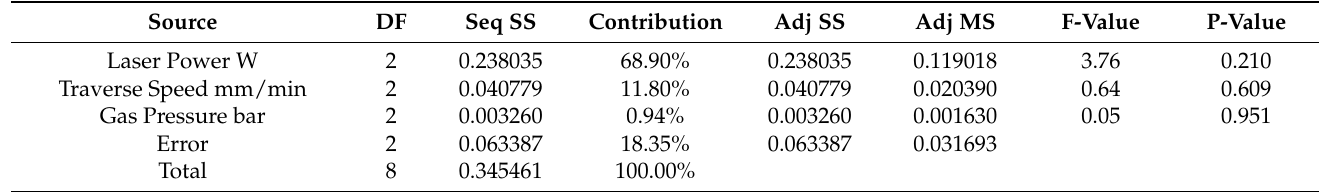
Table 12. ANOVA table for kerf taper angle response of input cutting parameters of 4 mm thickness of SPF-UPE composite cut by the laser beam cutting process.